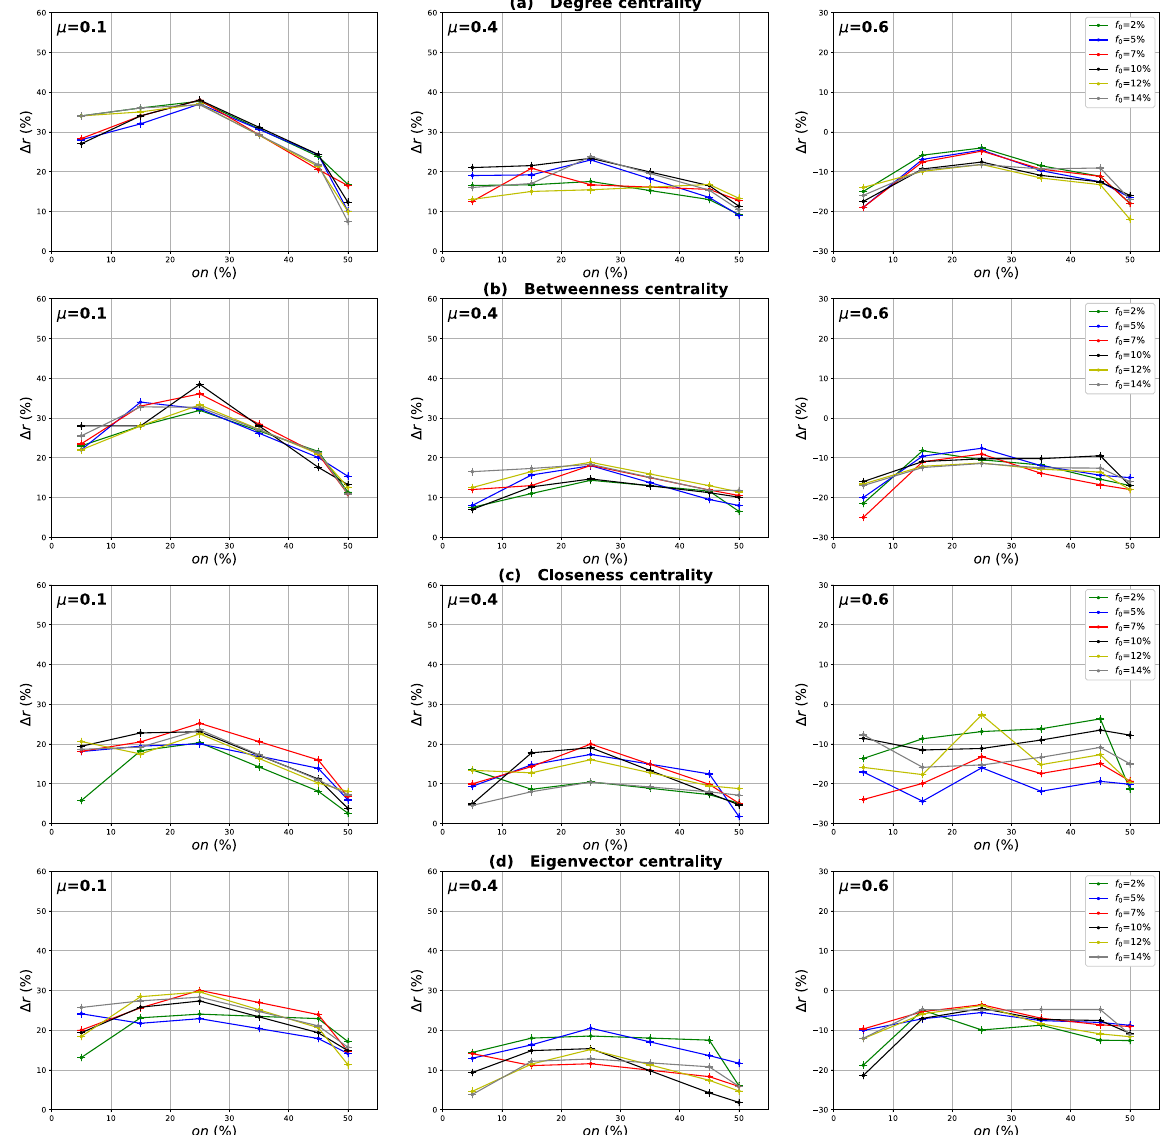
Figure 7. Influence of the number of overlapping nodes. The relative difference of the outbreak size Δ r between the standard measure and the Local measure versus the percentage of the overlapping nodes on . The community membership value om is equal to 10% of the total number of